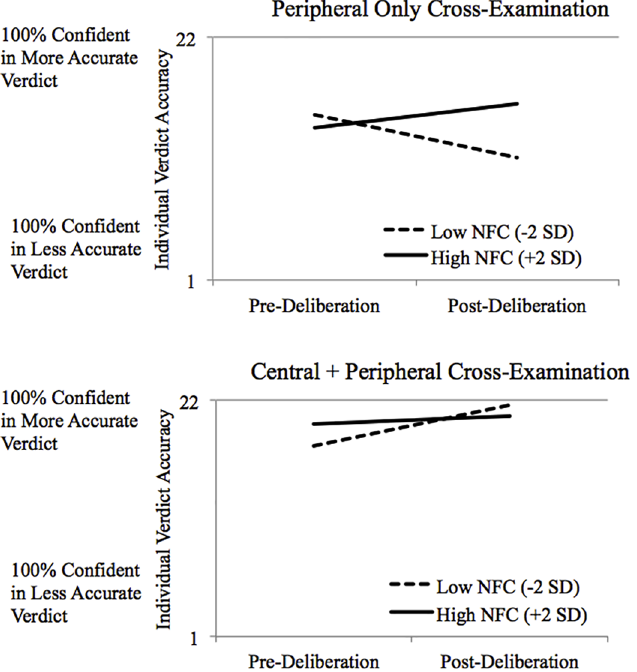
Fig 3. Individual verdict accuracyas a function of pre- versus post-deliberation, NFC, and cross- examination type